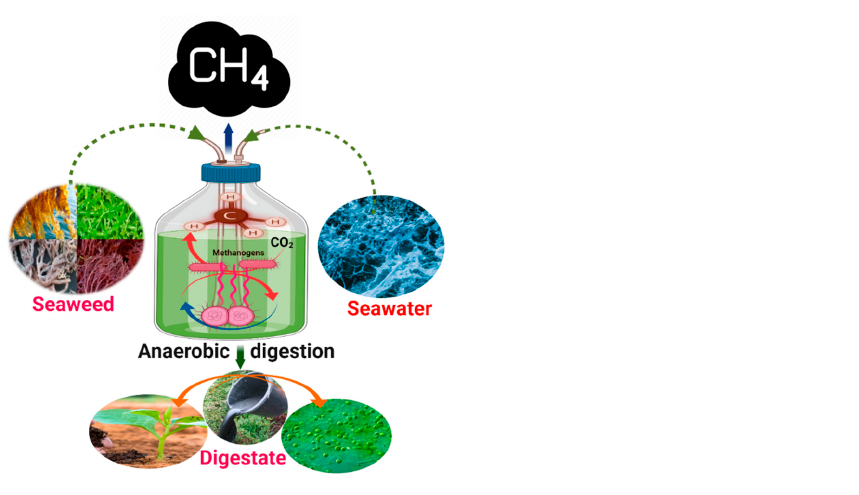
Figure 3. Overview of anaerobic digestion using marine-based resources (seaweed and seawater).